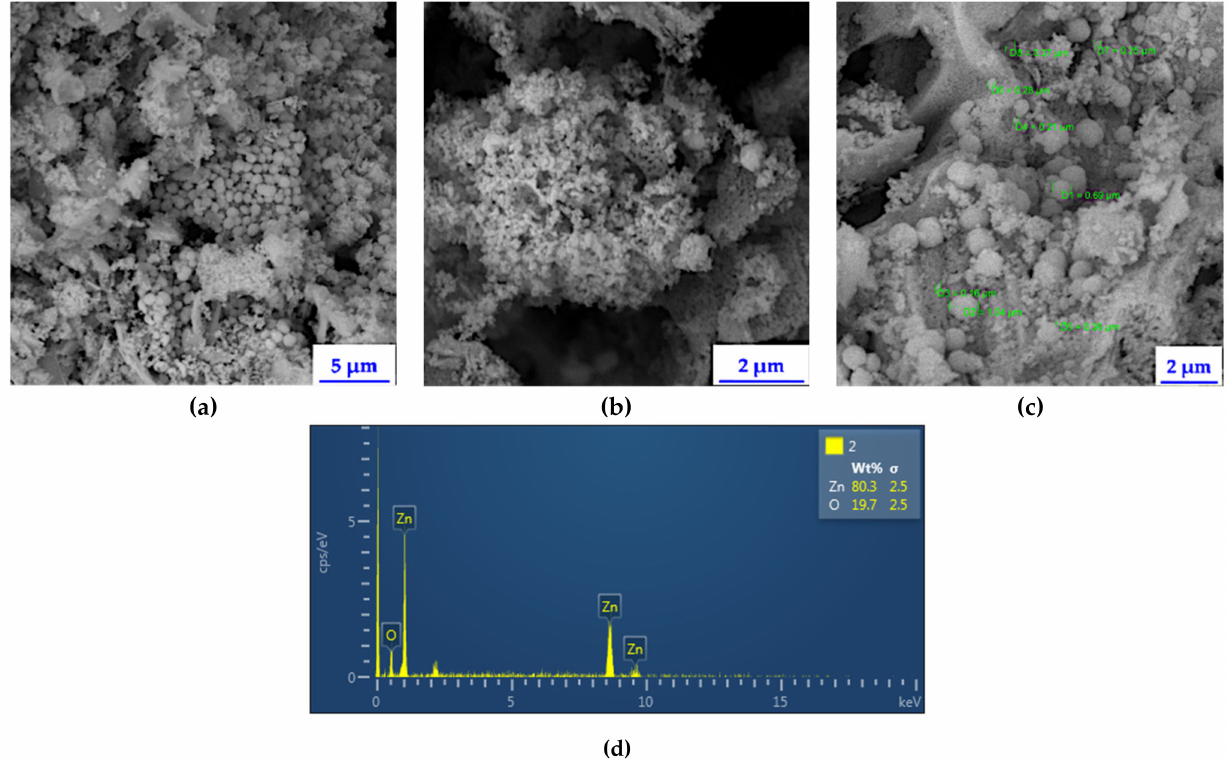
Figure 3. SEM images of ZnO Nitrate (heat treated) sample: ( a ) 10,000 × magnification (5 µ m marker); ( b ) 30,000 × magnifi- cation (2 µ m marker); ( c ) 20,000 × magnification (2 µ m marker) with particle size markers; ( d ) EDS elemental